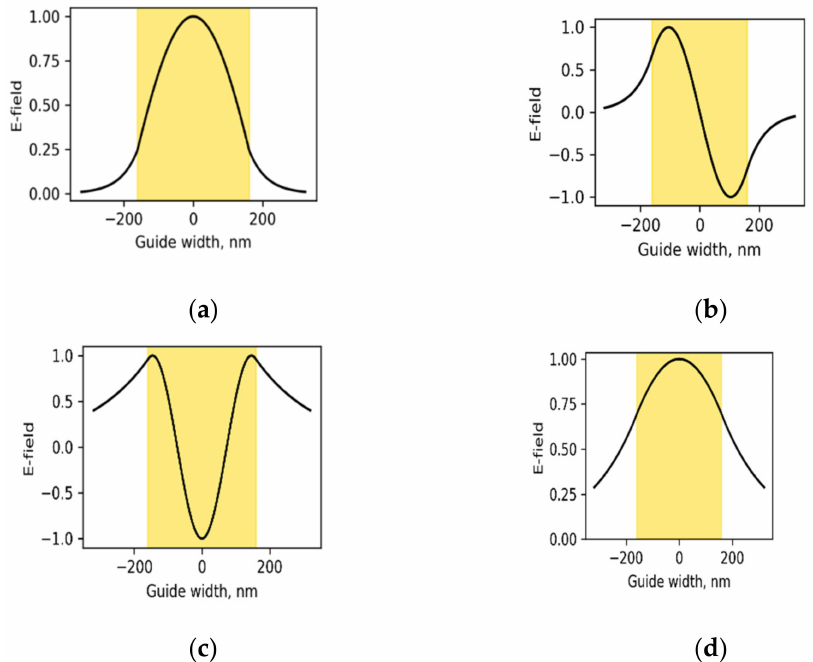
Figure 5. Normalized transverse electric field (TE m ) profiles in PDMS/PDMS–AAP/PDMS buried waveguide for 340 nm wavelength in trans state of core: ( a ) fundamental mode, m = 0, ( b ) m = 1 and ( c ) m = 2. Cis state: ( d ) m = 0, all modes shift down to this fundamental mode with normalized wave frequency of 2.4. Shaded region is waveguide